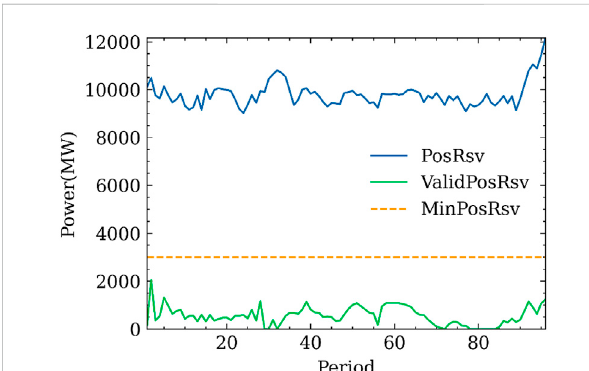
FIGURE 4 Comparison diagram of system positive reserve, effective positive reserve, and positive reserve demand.